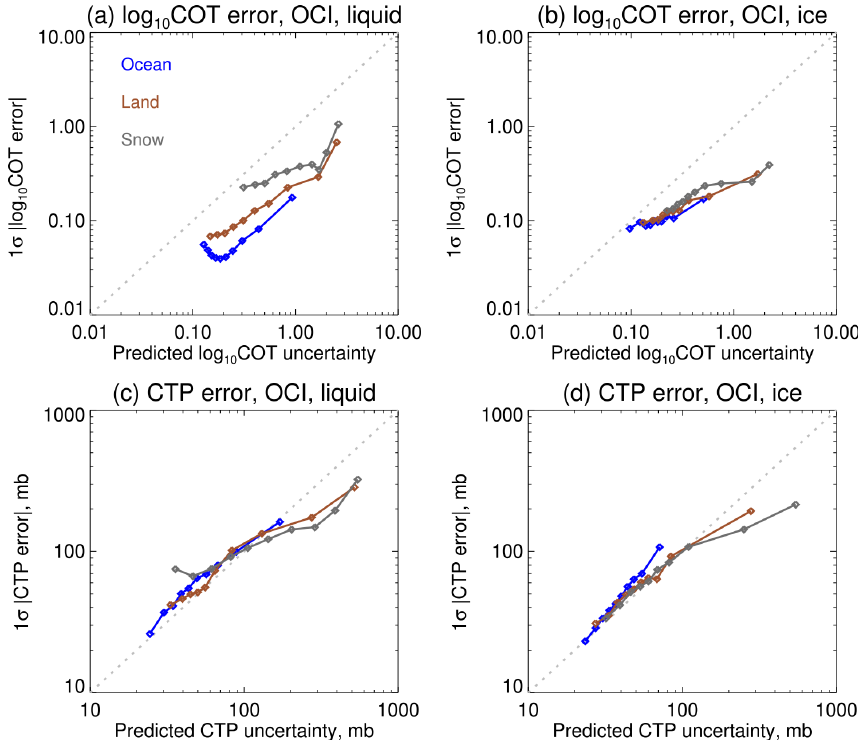
Figure 16. The 1 σ points of absolute retrieval error binned as a function of OE-provided retrieval-level uncertainty estimate for the case where cloud phase is known beforehand. Blue, brown, and grey indicate ocean-like, land-like, and snow-like simulations. Panels (a) and (b) show COT and (c) and (d) CTP. Panels (a) and (c) show results for liquid-phase simulations and (b) and (d) for ice-phase simulations. The 1 : 1 line (representing perfect agreement with theory) is